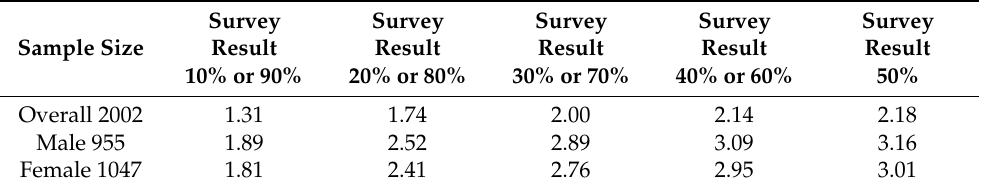
Table 1. MOE for different survey results [%]